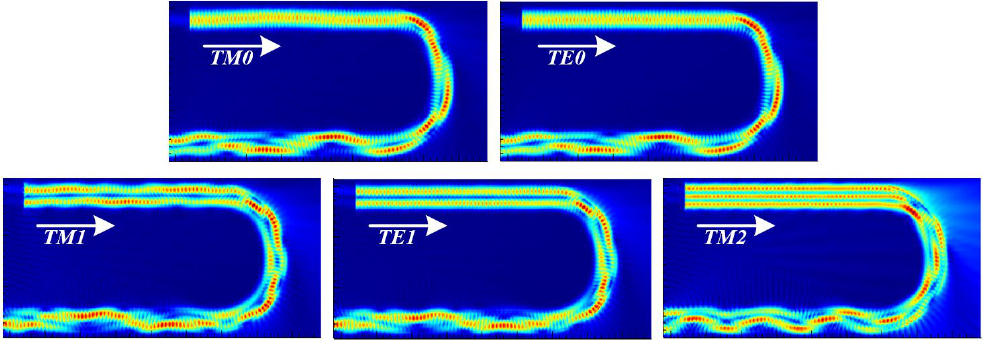
Figure 4. E-field profile of each mode in the semi-circle.